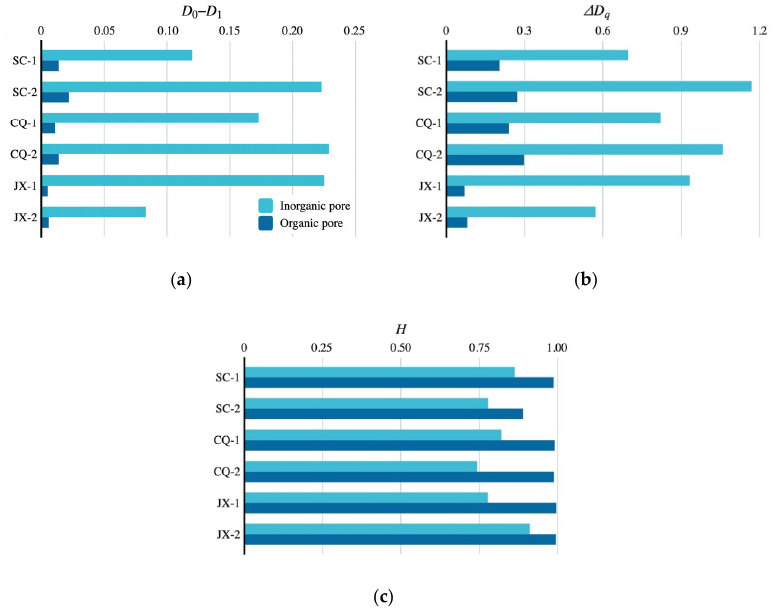
Figure 6. Comparison of the characteristic parameters from generalized fractal spectra between organic and inorganic pores: ( a ) D 0 − D 1 , ( b ) ∆ D q , ( c ) H .